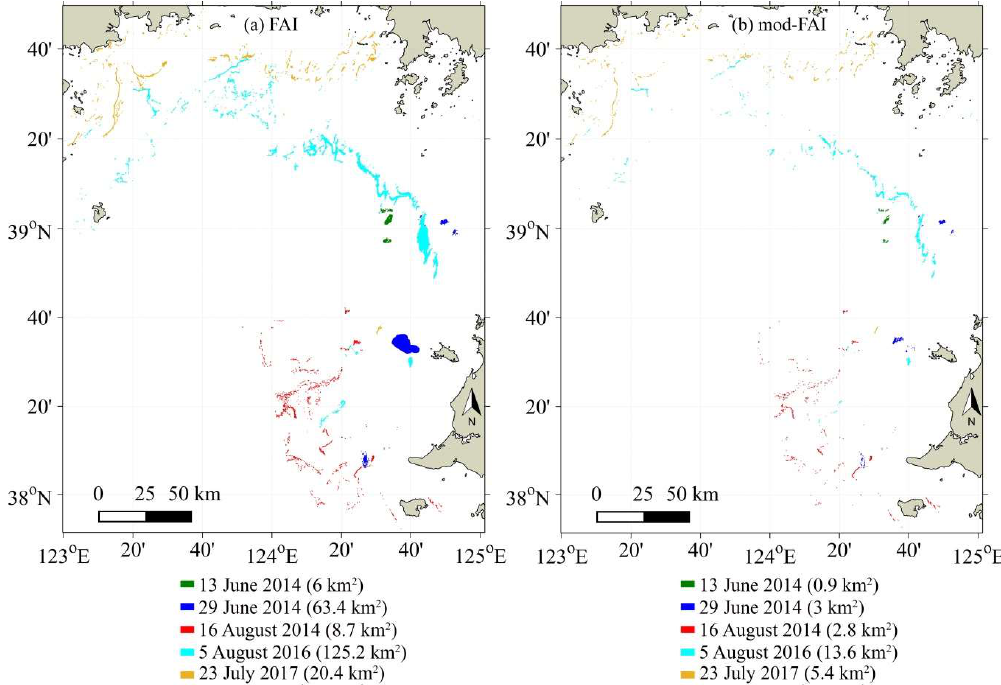
Figure 11. Detection results of macroalgae from Landsat-8 modified FAI images for path/row 118/32 and 118/33. Detected macroalgae pixels are exaggerated in size for better visibility. For the map area refer to the smaller dashed rectangle Figure 1.